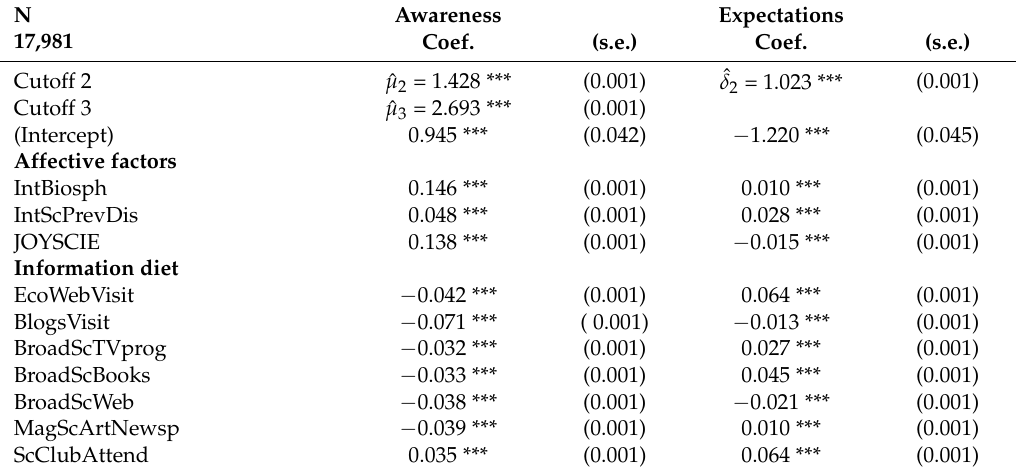
Table A4. MLE Results for Youth’s NPT Awareness and Expectations within